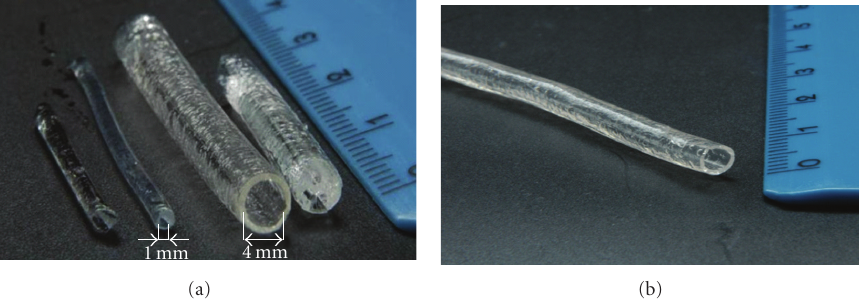
Figure 11: AGMA1 tubular hydrogels obtained by UV photopolymerization